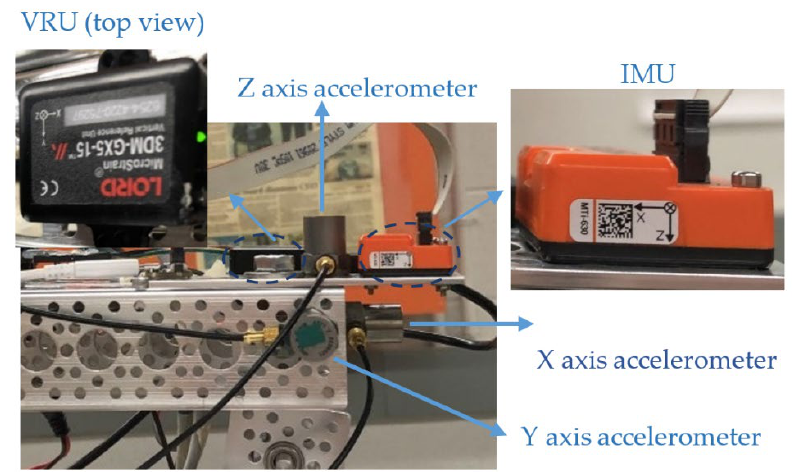
Figure 21. Experimental Modal analysis setup, locations of accelerometers, IMU and VRU sensors attached to the manipulator top-link end-point.